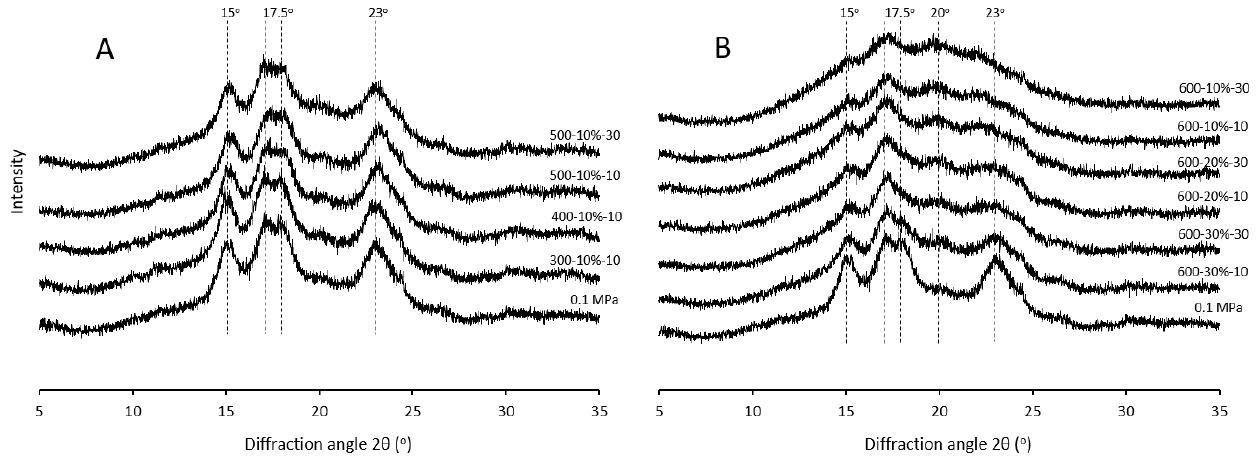
Figure 5. X-ray diffraction spectra of untreated (0.1 MPa) and selected HPP-treated cassava flours; where ( A ) shows spectra for untreated, 300 to 500–10%–10, and 500–10%–30, and ( B ) shows spectra for untreated and all 600 MPa treatment